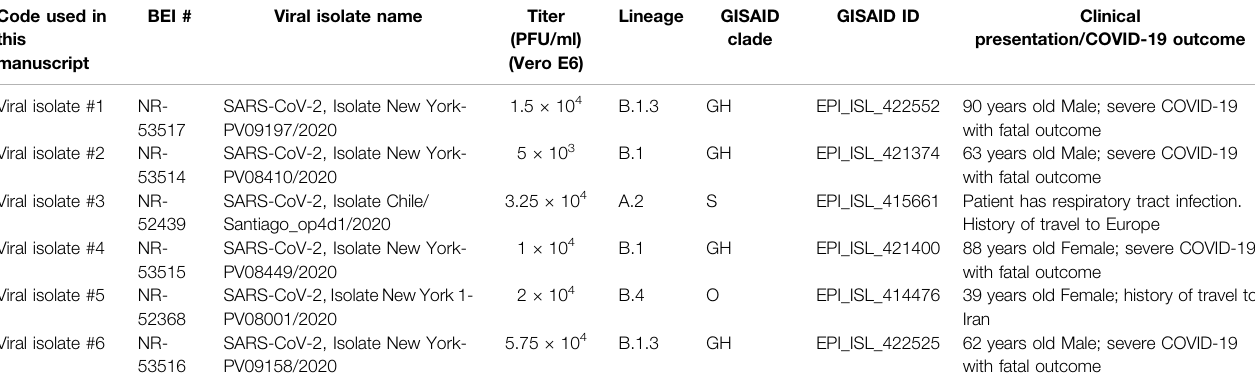
TABLE 1 | Summary of the SARS-CoV-2 isolates used in this